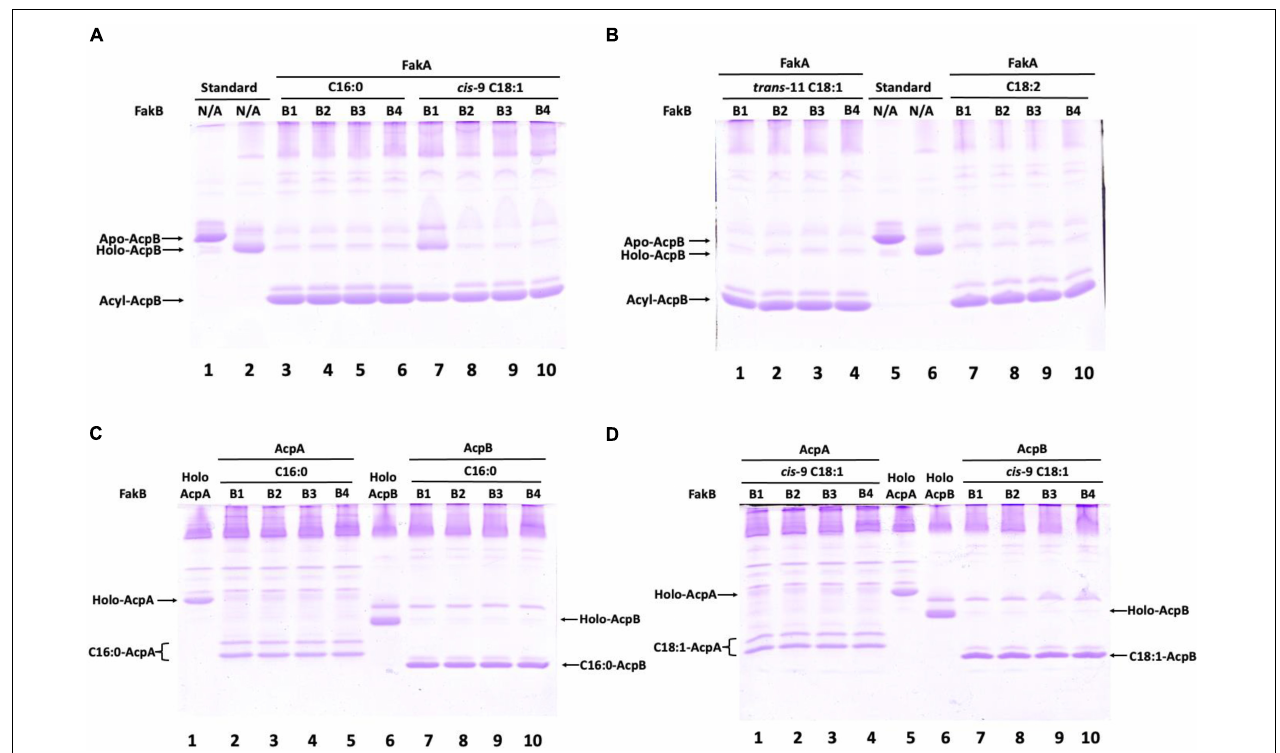
FIGURE 5 | Enterococcus faecalis acyl-AcpB is formed by the Fak-PlsX system in vitro . (A) Synthesis of palmitoyl-AcpB and oleoyl-AcpB by the E. faecalis Fak-PlsX system. (B) Synthesis of trans -vaccenoyl-AcpB and linoleoyl-AcpB by the E. faecalis Fak-PlsX system. (C) Relative synthesis of palmitoyl-AcpA and palmitoyl-AcpB by the E. faecalis Fak-PlsX system. (D) Relative of synthesis of oleoyl-AcpA and oleoyl-AcpB by the E. faecalis Fak-PlsX